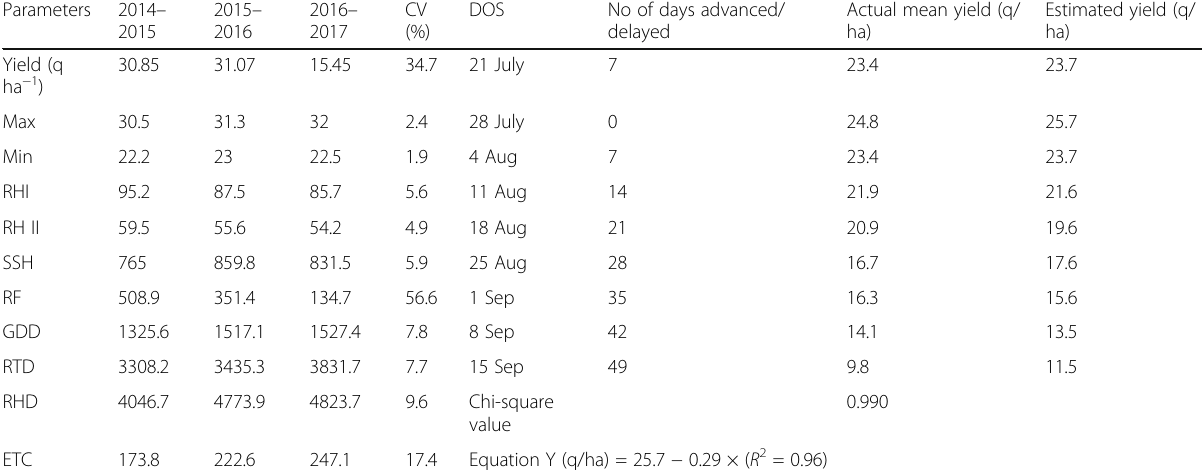
Table 10 Prevailed weather parameter in high performing treatments in different years